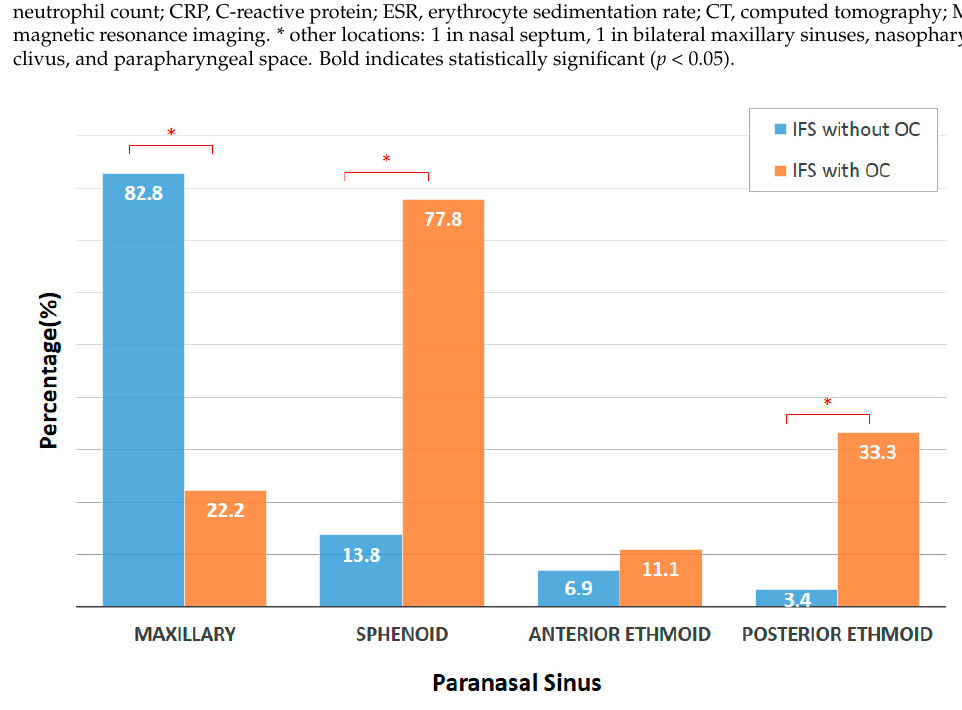
Figure 1. Sinus involvement in IFS. (* statistically significant ( p < 0.05)).